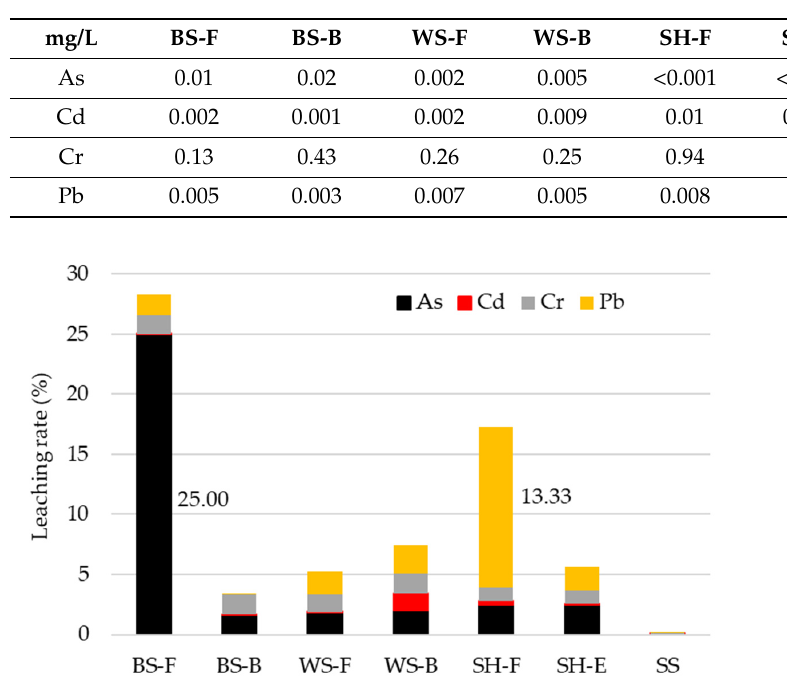
Figure 5. Leaching rates of heavy metals from ABAs. Based on Croatian regulation [58], which is in accordance with European Directives dealing with wastewater treatment, the emission limits of heavy metal pollution in surface wastewater are shown in Table 8. EPA United States national regulatory standards for wastewater discharged to surface waters and municipal sewage treatment plants is pre- sented for the daily maximum limits of the World Health Organization from a year 2006 (WHO). Table 8. Limit values of heavy metal emission for surface wastewater discharges. Element